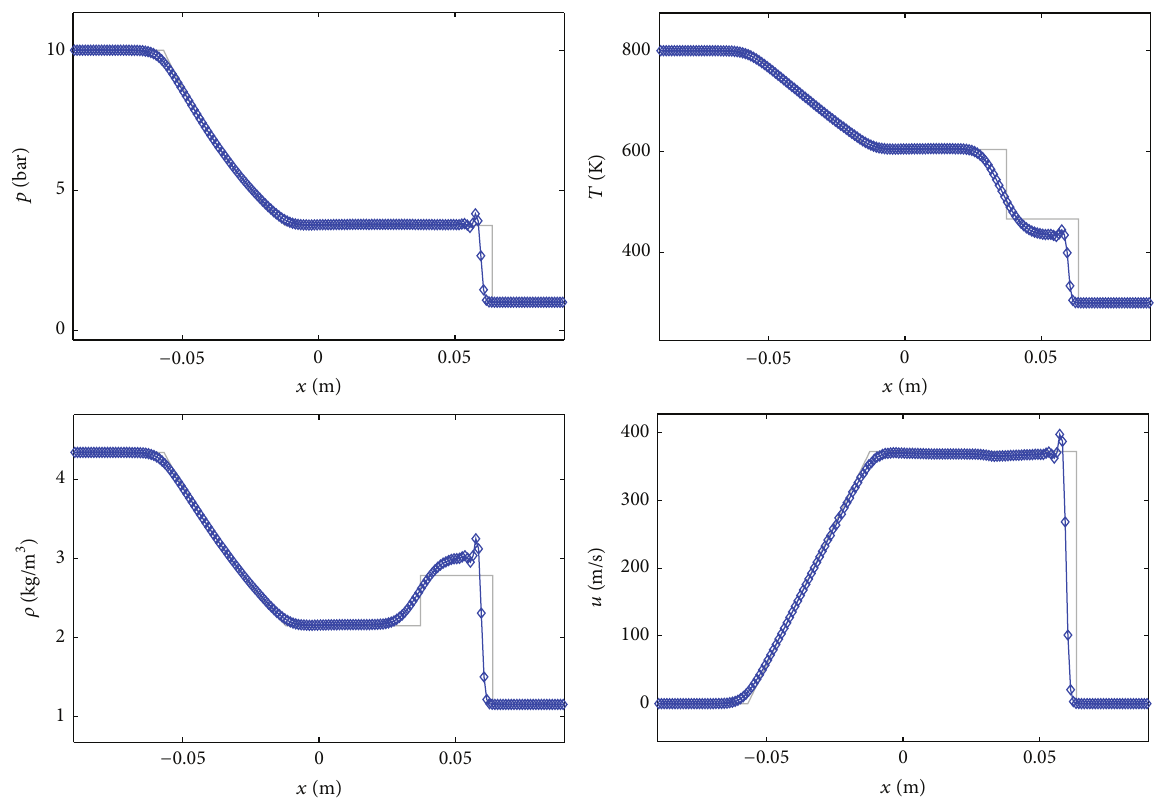
Figure 1: Results of shock-tube calculation with PISO